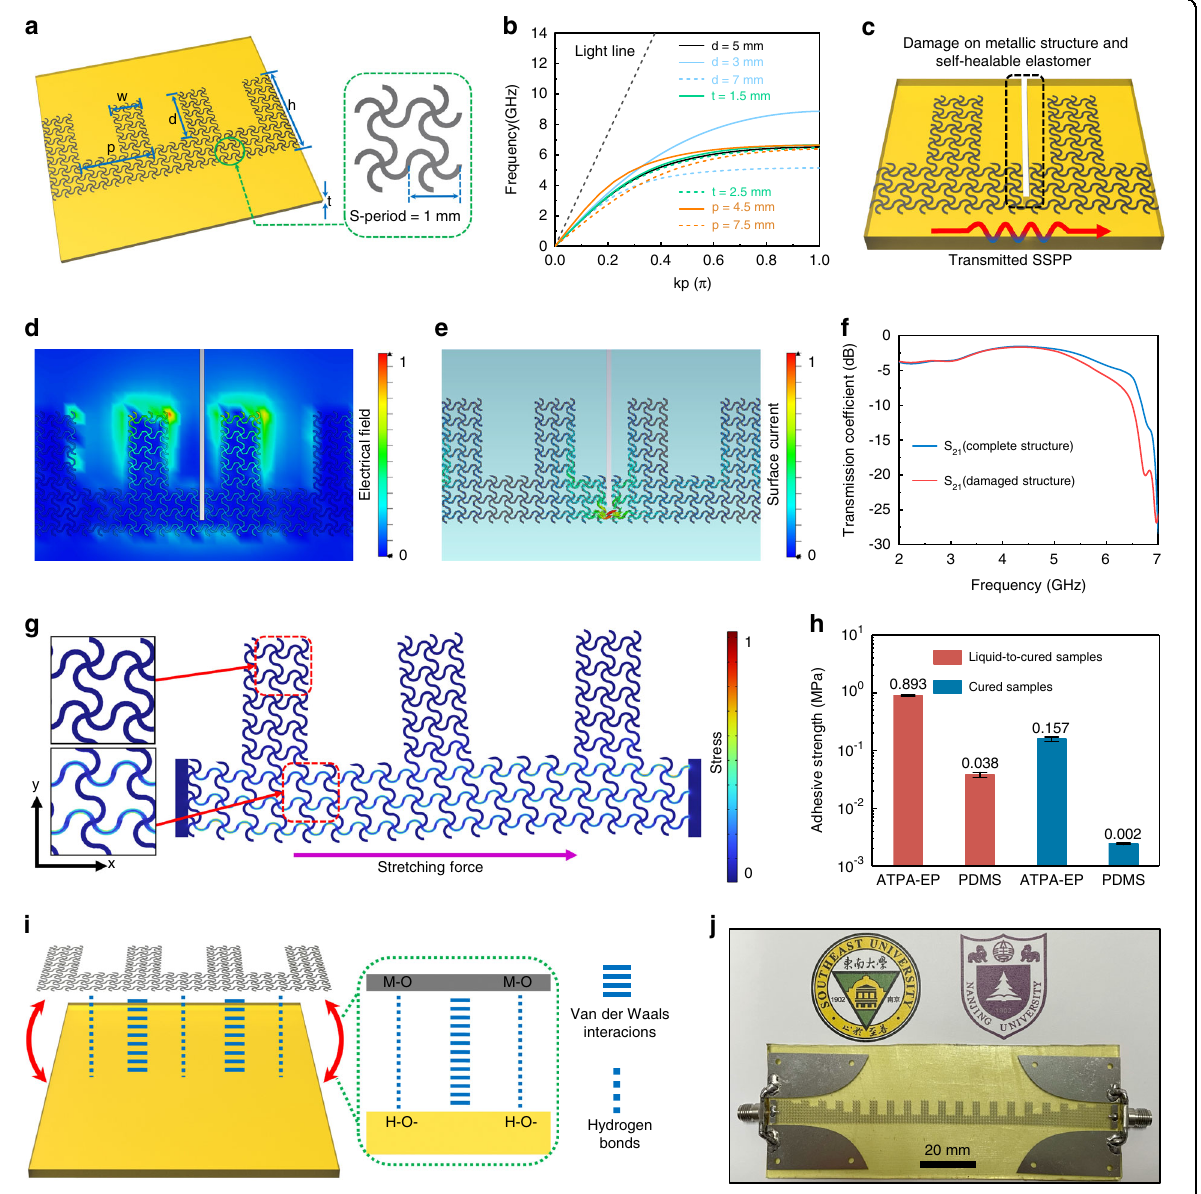
Fig. 3 Design and fabrication of the self-healable and stretchable spoof plasmonic meta-waveguide. a Serpentine-type plasmonic metamaterial unit. b Simulated dispersion curves of the plasmonic metamaterial unit. c Illustration of the damaged structure. d Simulated electrical fi eld and e surface current distribution of the damaged meta-waveguide. f Transmission coef fi cient comparison between damaged and complete meta-waveguides. g Mechanical strain simulation of the proposed stretchable meta-waveguide. h Measured adhesive strength of ATPA-EP and PDMS on the steel surface. i Illustration of the integration between the epoxy polyimide elastomer (ATPA-EP) and metallic structure. j Photograph of the fabricated spoof plasmonic